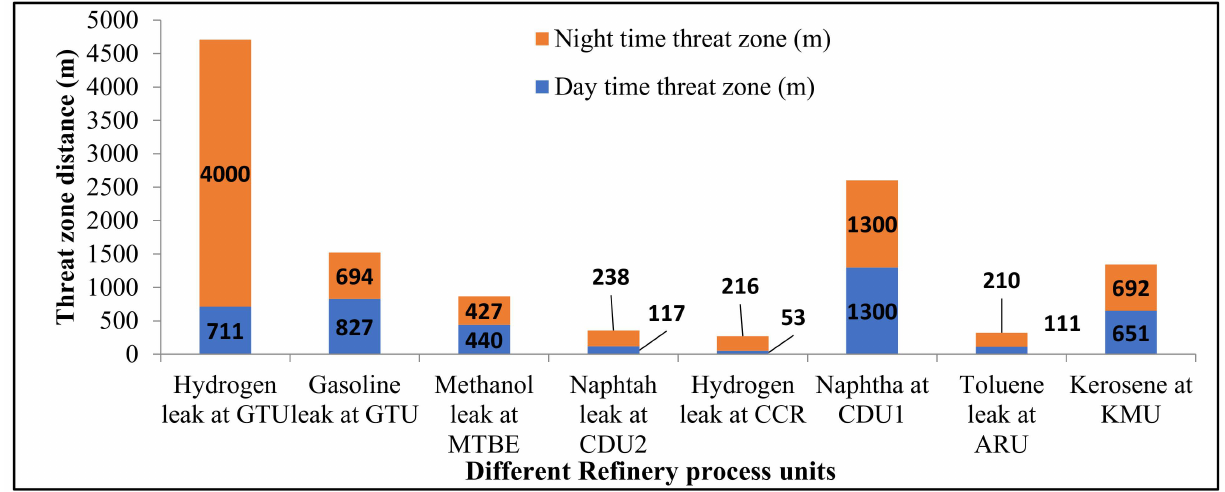
Figure 4. Threat zones for a flammable area of the vapor cloud.